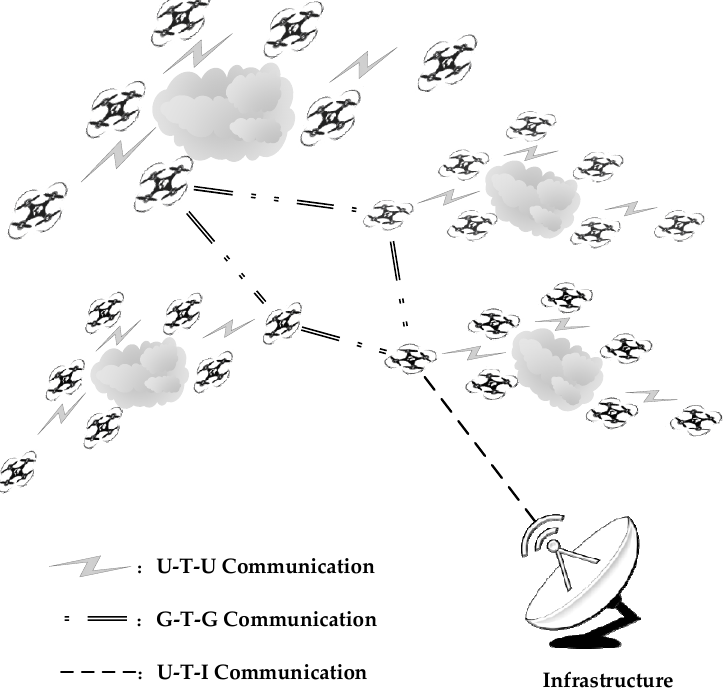
Figure 5. Schematic of multi-layer swarm Ad hoc network.